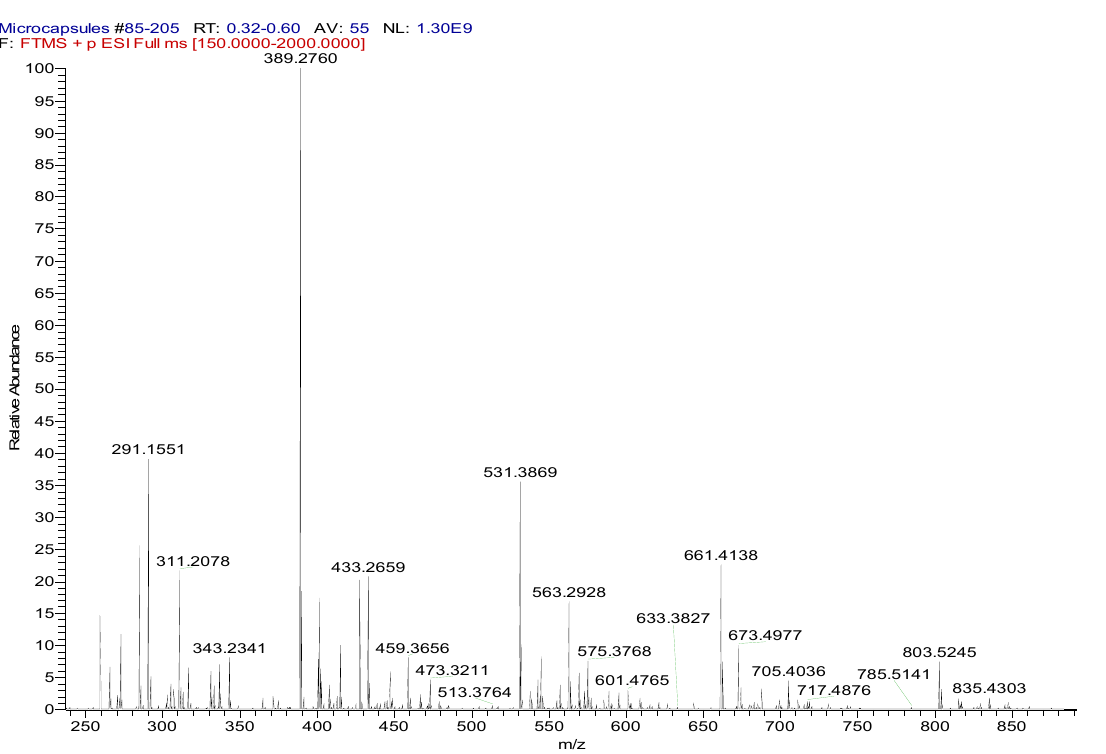
Figure 14. ESI mass spectrometry data for polyurea formaldehyde.